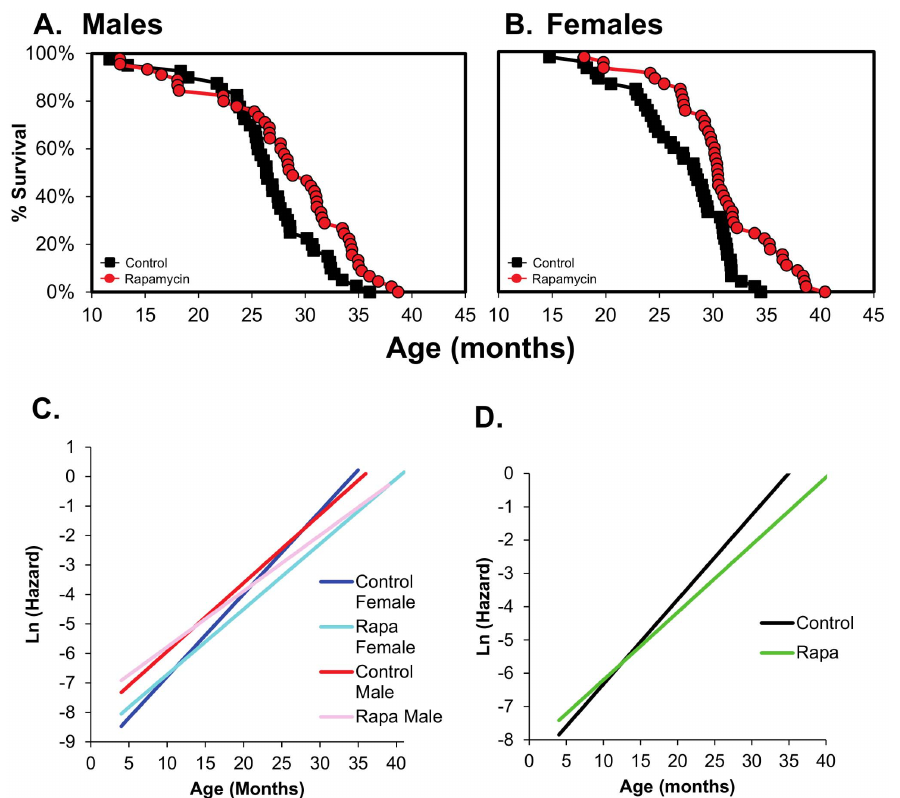
Figure 1. Rapamycin extends the lifespan of male and female C57BL/6 mice fed rapamycin. Survival curves are shown for male ( A ) and female ( B ) C57BL/6 mice fed diets containing eudragit (control, black boxes) or Rapa (red circles) starting at 4 months of age. Forty mice were in the control male group and 45 mice each in the Rapa male, control female, and Rapa female groups. The survival data were statistically analyzed using Cox proportional hazard and Weibull’s survival model. The Cox proportional hazard test shows Rapa-fed mice are 47% and 58% less likely to die at the same age as the controls in males (p=0.004) and females (p , 0.001) respectively. The Weibull survival model shows that Rapa-fed male and female have an extension of 11% and 16%, respectively, beyond the controls with p=0.006 in males and p , 0.001 in females. The statistical analysis of the mean, 80%, 50%, 10%, and maximum survival are given in Table S1 in File S1. Ln plots of fitted Gompertz mortality models where the hazard (instantaneous mortality rate) at age x, u x =ae bx with x beginning at 4 months and continuing until the end of life. Models were first fitted to each sex and diet group separately and shown in ( C ). Control males are in red, Rapa males in pink, control females in blue, and Rapa females in cyan. Because the sexes did not differ under control or Rapa treatment using maximum-likelihood estimation, we combined the sexes and compared Rapa to Control diets irrespective of sex ( D ). Combined sex controls in black and combined sex Rapa in green. Pooling of the sexes allowed for identifying the parameter(s) that differ between Rapa and control-fed animals, and indicates that the rate of aging ( b ), but not the initial mortality rate ( a ), differed between Rapa and control mice.